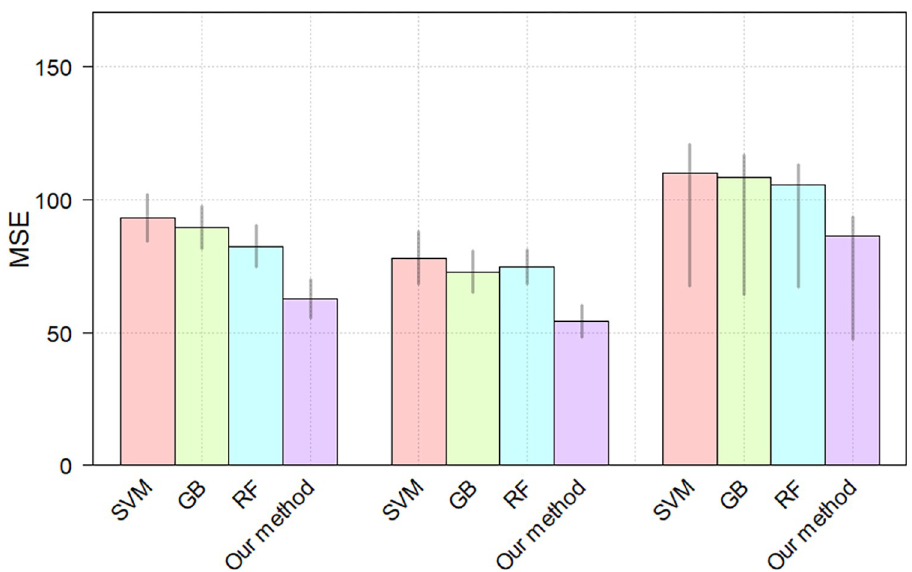
Fig 8. The MSEs of different methods. The heights of the bars denote the means, gray lines denote the 95% confidence intervals.